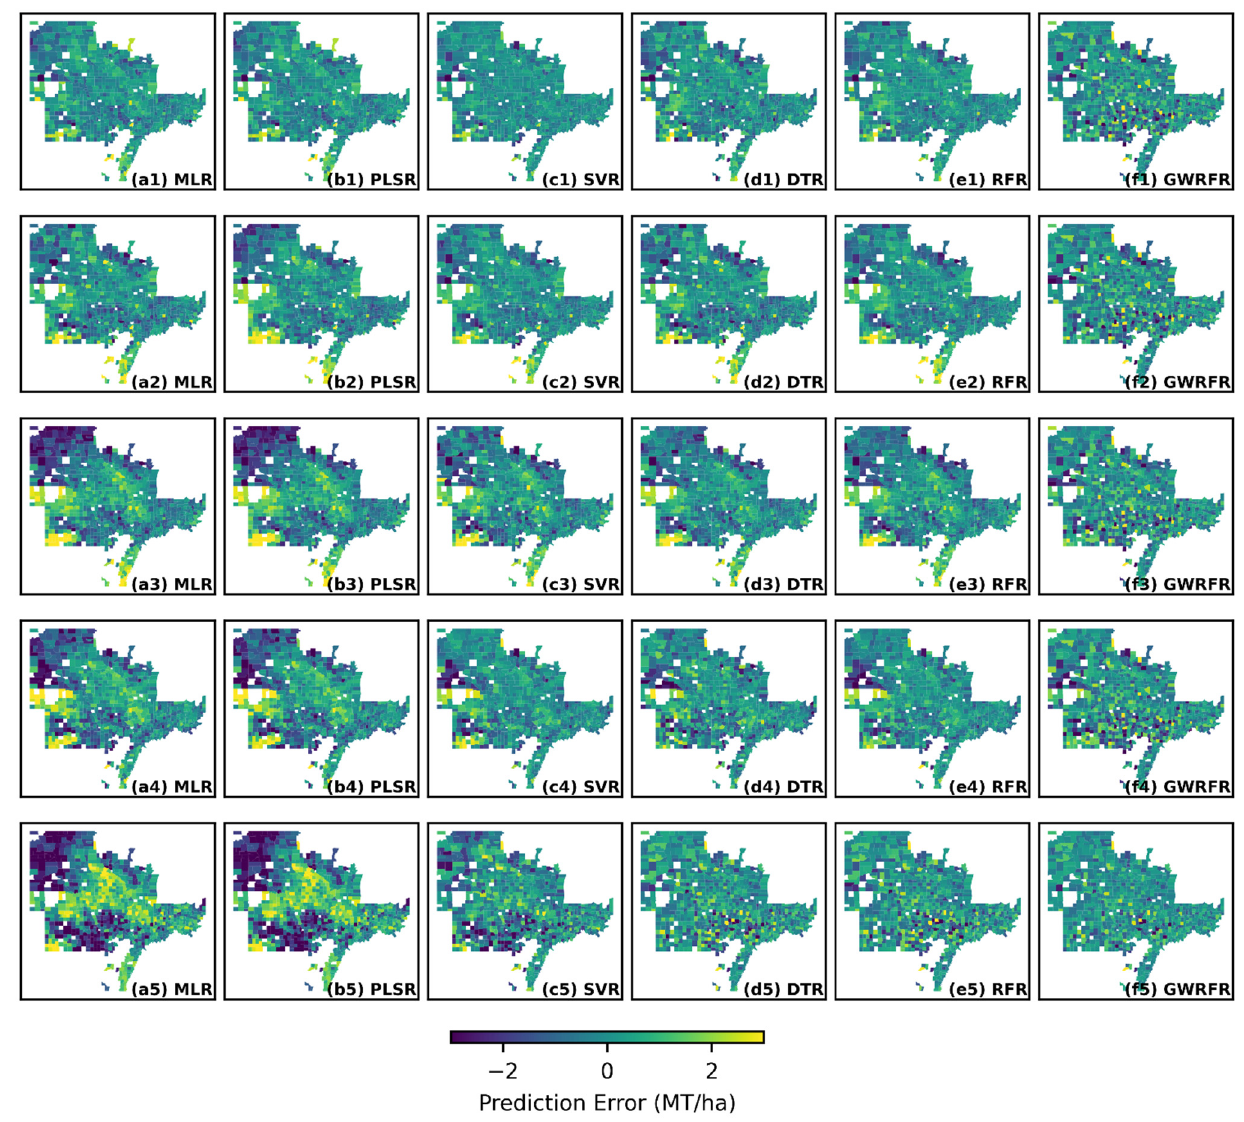
Figure 10. The spatial distribution of prediction errors of ( a ) MLR, ( b ) PLSR, ( c ) SVR, ( d ) DTR, ( e ) RFR, and ( f ) GWRFR using (1) full-length features, (2) vegetation indices derived from RS data, (3) GPP, (4) climate data, and (5) soil data.